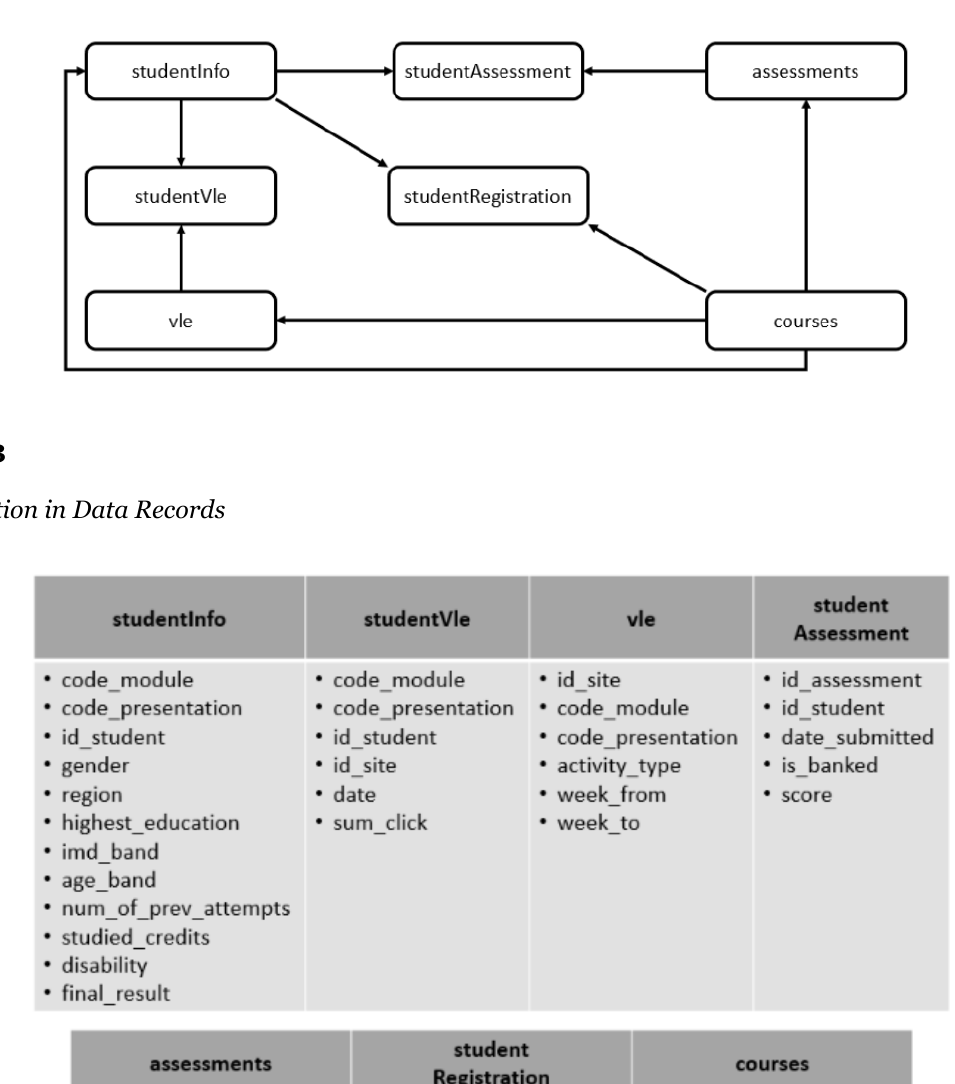
Figure 2 Structure of Data Set